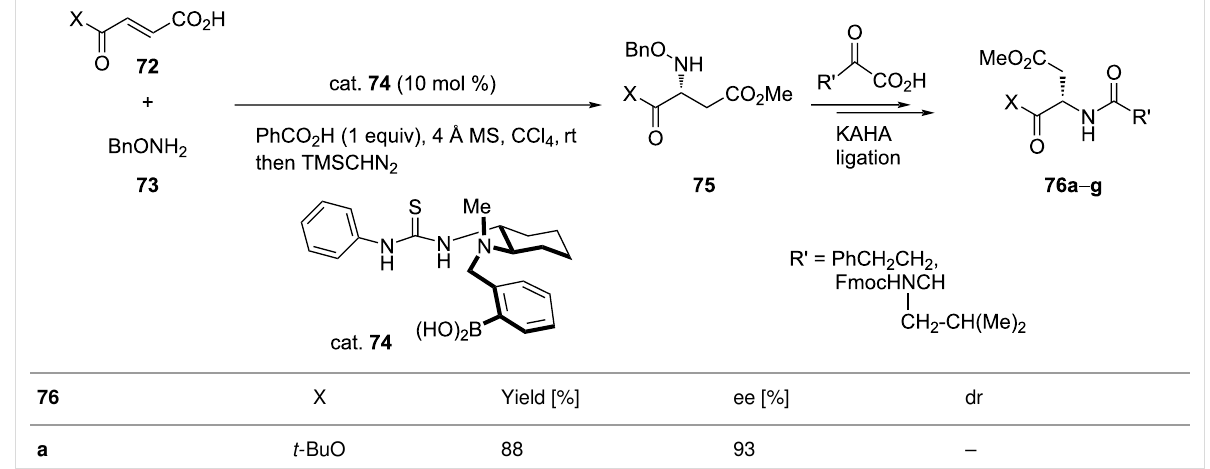
Table 17: Asymmetric aza-Michael addition reaction for the synthesis of N- hydroxyaspartic acid derivatives catalyzed by chiral multifunctional thio- urea/boronic